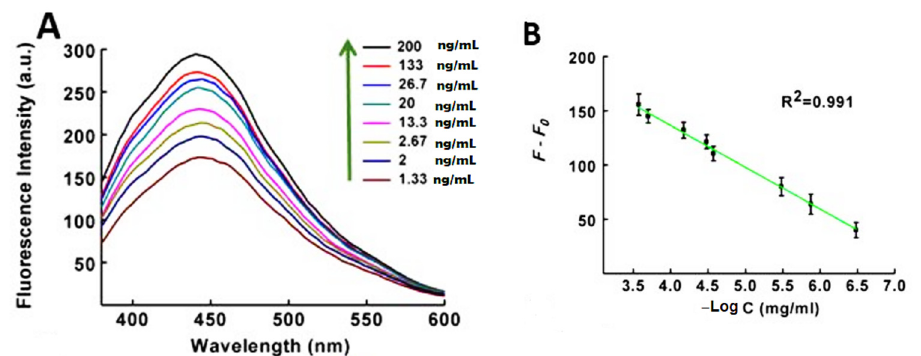
Figure 11. ( A ) Fluorescence spectra of the assaying model in the presence of varying concentrations of MUC1. ( B ) The linear relationships between F-F0 and the concentrations of MUC1. Reprinted with permission from Ref.[174]. Copyright 2018, Elsevier.